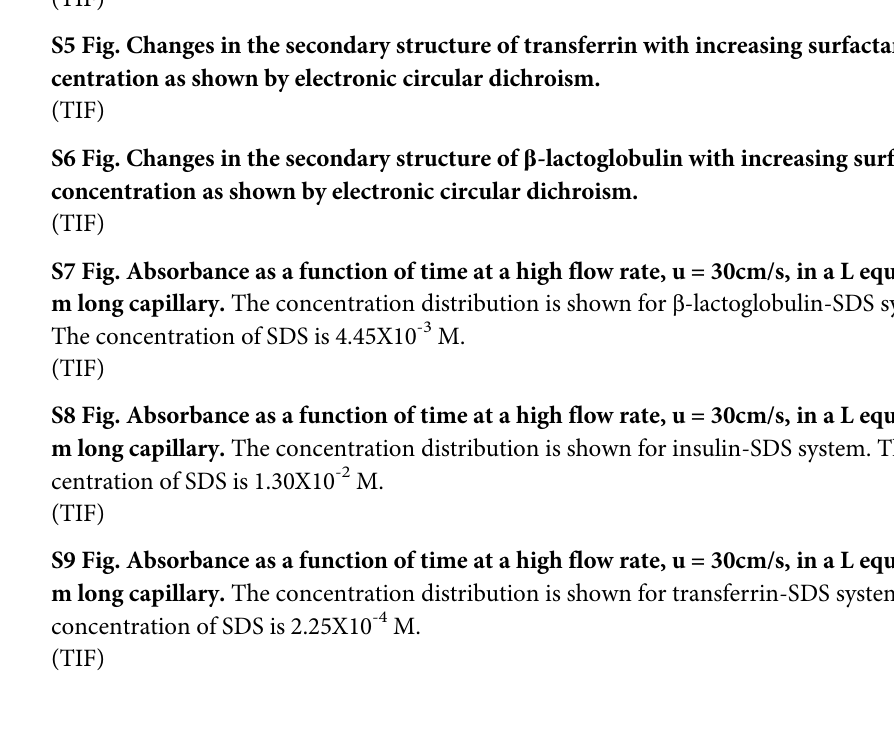
S1 Table. Summary of ECD experiments for proteins under investigation. S1 Fig. Changes in the tertiary structure of β -lactoglobulin with increasing surfactant con- centration as shown by electronic circular dichroism. S2 Fig. Changes in the tertiary structure of human insulin with increasing surfactant con- centration as shown by electronic circular dichroism. S3 Fig. Changes in the tertiary structure of transferrin with increasing surfactant concen- tration as shown by electronic circular dichroism. S4 Fig. Changes in the secondary structure of human insulin with increasing surfactant concentration as shown by electronic circular dichroism. S5 Fig. Changes in the secondary structure of transferrin with increasing surfactant con- centration as shown by electronic circular dichroism. S6 Fig. Changes in the secondary structure of β -lactoglobulin with increasing surfactant concentration as shown by electronic circular dichroism. S7 Fig. Absorbance as a function of time at a high flow rate, u = 30cm/s, in a L equals * 30 m long capillary. The concentration distribution is shown for β -lactoglobulin-SDS system. The concentration of SDS is 4.45X10 -3 M. S8 Fig. Absorbance as a function of time at a high flow rate, u = 30cm/s, in a L equals * 30 m long capillary. The concentration distribution is shown for insulin-SDS system. The con- centration of SDS is 1.30X10 -2 M. S9 Fig. Absorbance as a function of time at a high flow rate, u = 30cm/s, in a L equals * 30 m long capillary. The concentration distribution is shown for transferrin-SDS system. The concentration of SDS is 2.25X10 -4